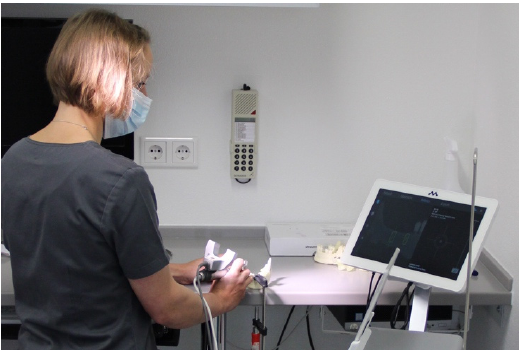
Figure 3. Implementing implantation under standardized laboratory conditions.